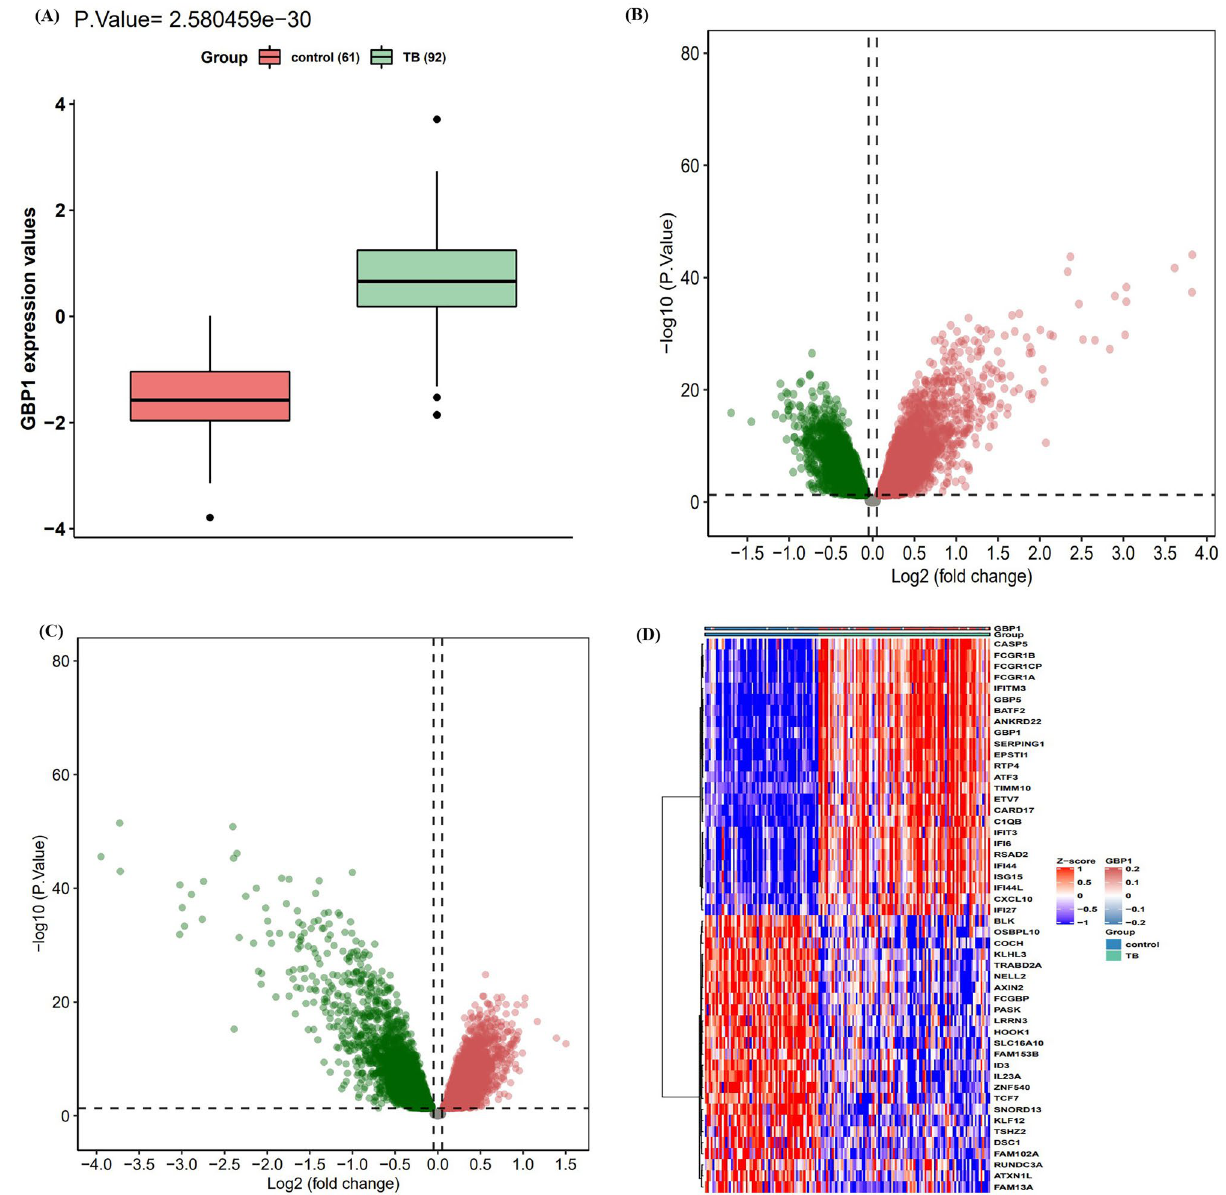
Figure 1. Differential expression gene analysis. ( A ) GBP1 is up-regulated in TB (P = 2.580e-30, 92 TB patients and 61 normal people). ( B ) Volcano plot of the TB-control, red represents up-regulated genes, blue represents down-regulated genes, and black represents no significantly differentially expressed genes. ( C ) Volcano plot of the GBP1-low/high, red represents up-regulated genes, blue represents down-regulated genes, and black represents no significantly differentially expressed genes. ( D ) A heatmap of 25 most up-regulated and 25 most down-regulated